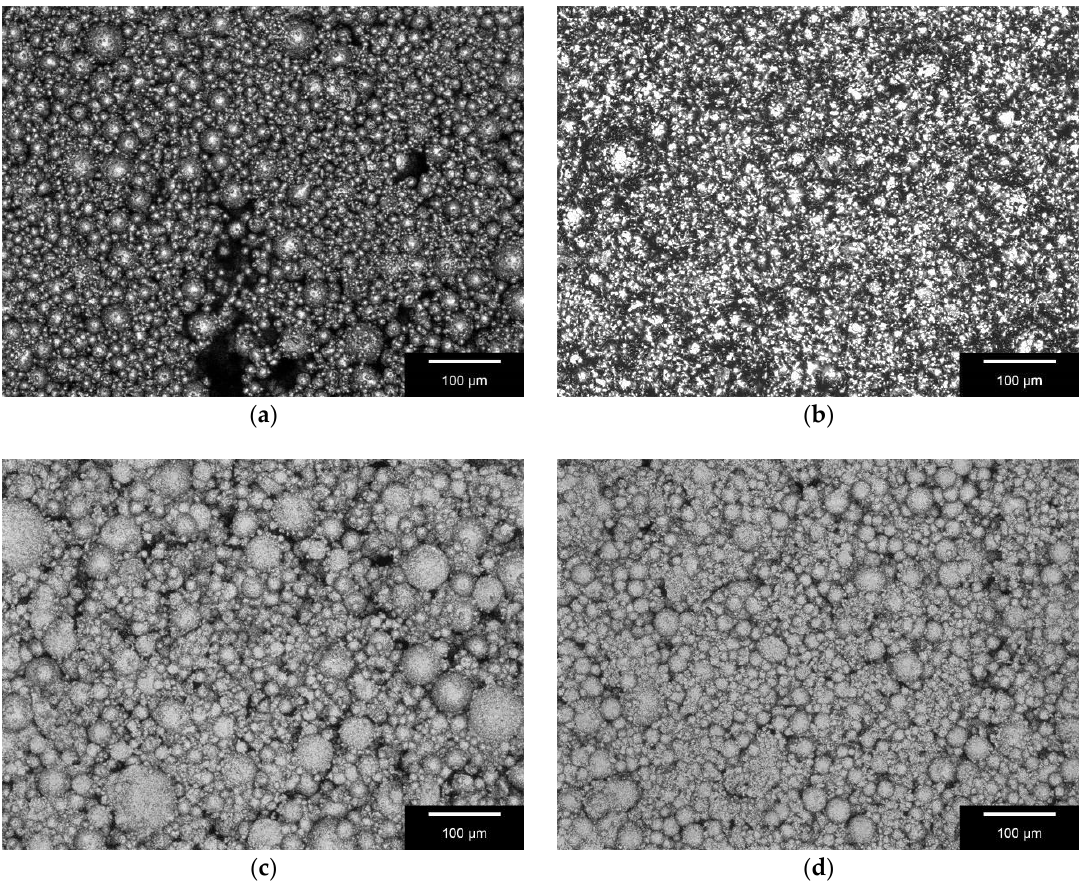
Figure 3. 3D Laserscanning Image of Samples Surface; Differences in the particle size of the used granules can be seen, as well as the presence of only a few sinter bridges: ( a ) BG; ( b ) β-TCP; ( c ) 50/50; and ( d ) 70/30. Scale bar = 100 µm. Images were taken with Keyence VK-X210 (Keyence, Osaka, Japan). Magnification, 400×.